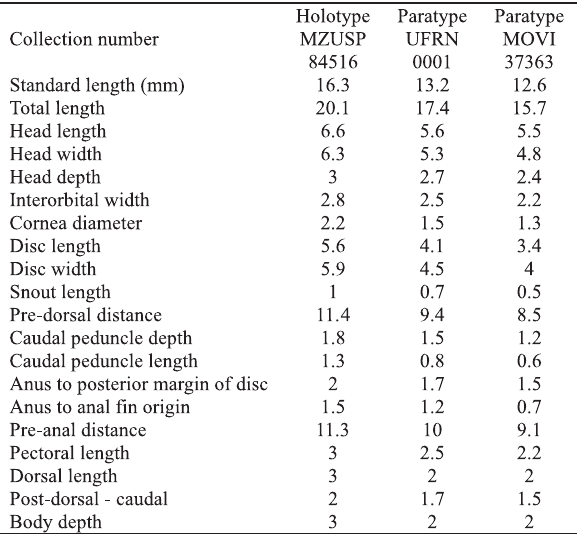
Table 1 . Morphometric and meristic characters for the holo- type and paratypes of Acyrtus pauciradiatus